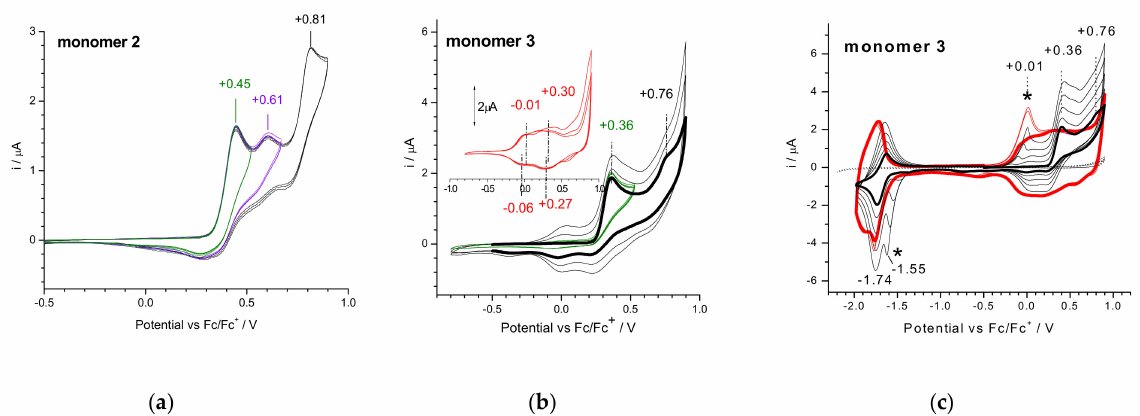
Figure 4. CVs limited after following oxidation peaks in 1 mM of 2 and 0.1 M Bu 4 NBF 4 / DCM ( a ); CVs of electrodeposition after first ( green ) and second ( black ) oxidation peak ( a , b ), potential sweep between second oxidation and first reduction peaks ( c ) in 1 mM of 3 and 0.1 M Bu 4 NBF 4 /DCM and polarization of solid p(3) ( red ) in monomer-free 0.1 M Bu 4 NBF 4 /DCM solution ( b , c ); first CV cycle (bold); charge-trapping peaks (*); 50